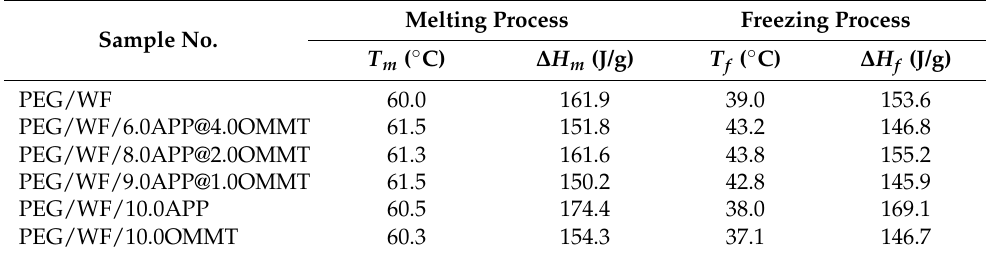
Table 4. Latent heat storage properties of PEG/WF and its composites after thermal cycling. Sample No.